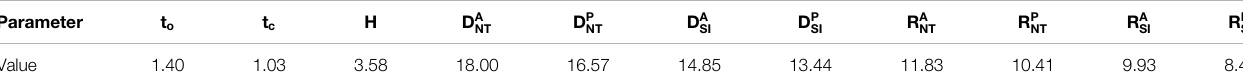
TABLE 1 | Geometrical parameters (unit in mm) for the fi nite element simulation of porcine cornea (Cornaggia et al., 2020). Parameter